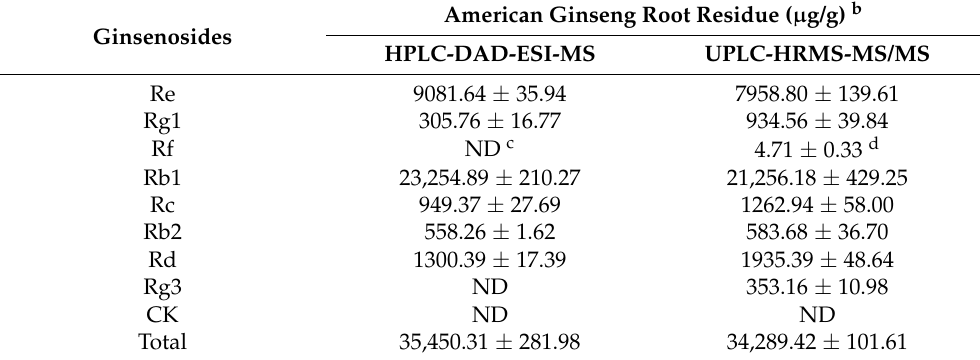
Table 2. Contents of ginsenosides in American ginseng root residue by HPLC-DAD-ESI-MS